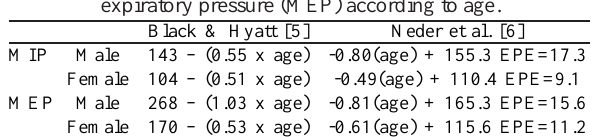
Table 1. Equations proposed by Black and Hyatt (1969) and Neder et al. (1999) to calculate predicted values of maximal inspiratory pressure (MIP) and maximal expiratory pressure (MEP) according to age.